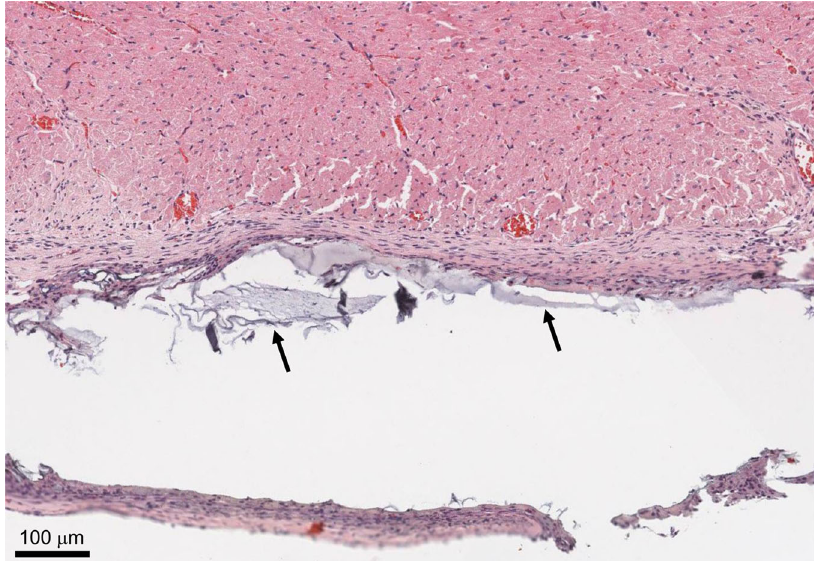
Fig. 6 Histology of Ald – AO – Cat in a rat model. H&E staining was performed for Ald – AO – Cat tissue samples ( n = 6 independent animals) to verify